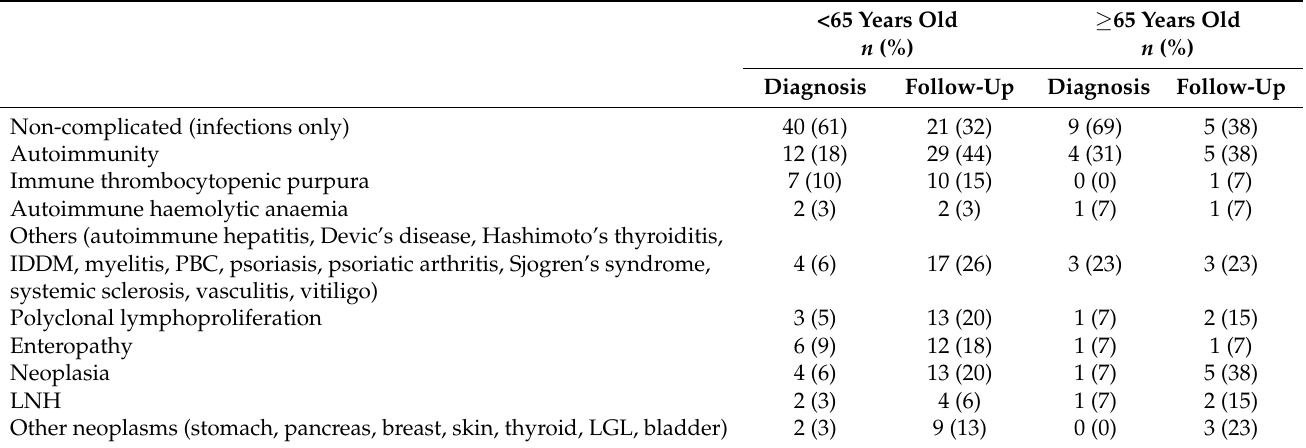
Table 3. Clinical phenotypes at CVID diagnosis and at last follow-up control.